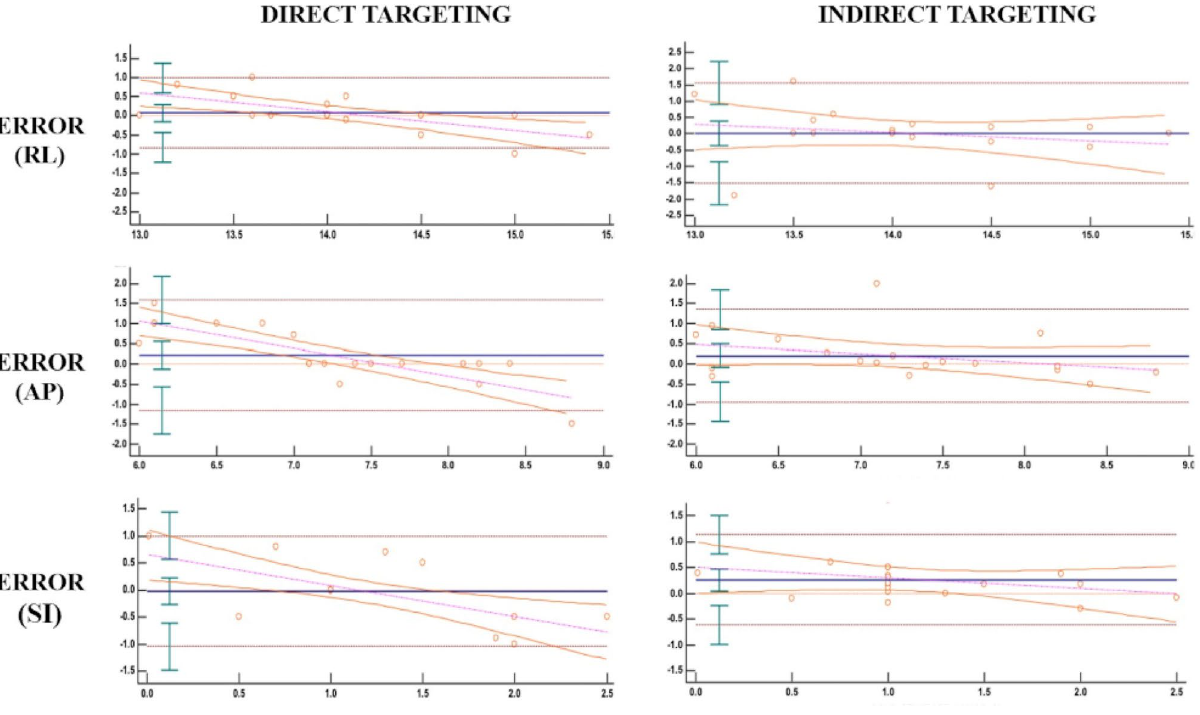
Figure 1. Bland Altman plots for direct and indirect targeting.